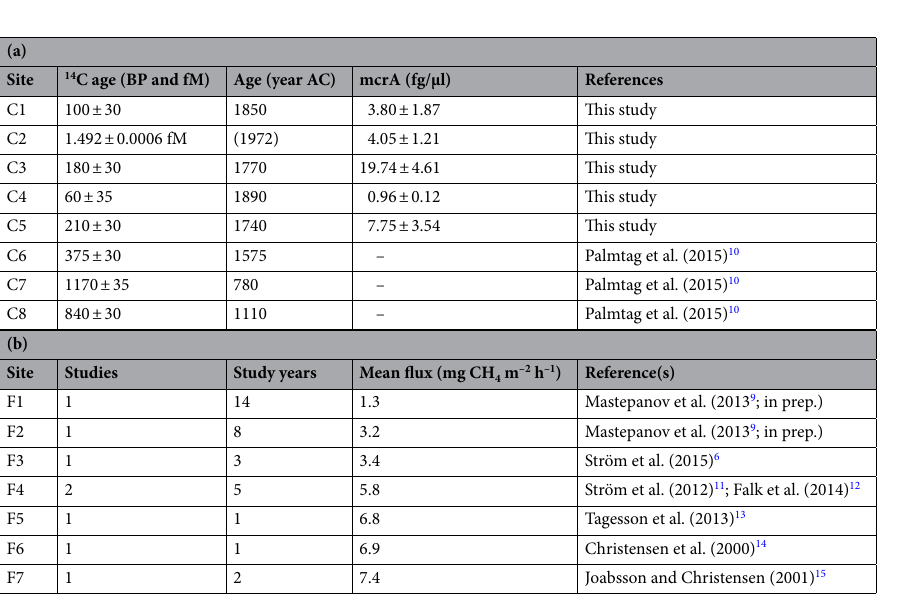
Table 1. Parameter tables for (a) location analysis including basal peat 14 C age and mcrA gene counts and (b) location of multiple years of comparable flux study sites. Site codes refer to Fig. 1. Radiocarbon ages are given in years in BP (before present = AD 1950) from 1650 to 1950 and in fM (fraction modern) for samples younger than 1963 (post-weapons